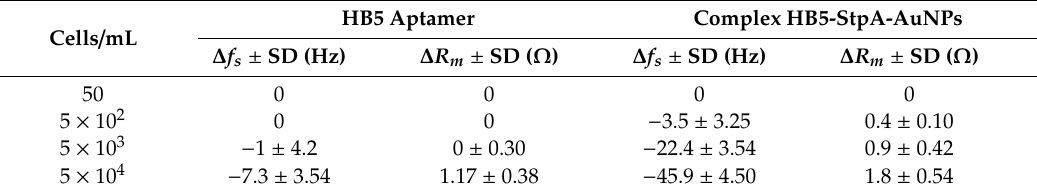
Table 2. Comparison of the changes of resonant frequency ( ∆ f s ) and motional resistance ( ∆ R m ) of TSM transducer after addition of 0.25 µ M HB5 aptamers and / or gold nanoparticles modified by HB5 aptamers (HB5-StpA-AuNPs) (concentration 1 µ g / mL) to a surface of HB5 based aptasensor with the immobilized breast cancer cells (SK-BR-3) of various concentrations. Results are mean ± SD obtained from 3 independent experiments in each series. HB5 Cells / mL